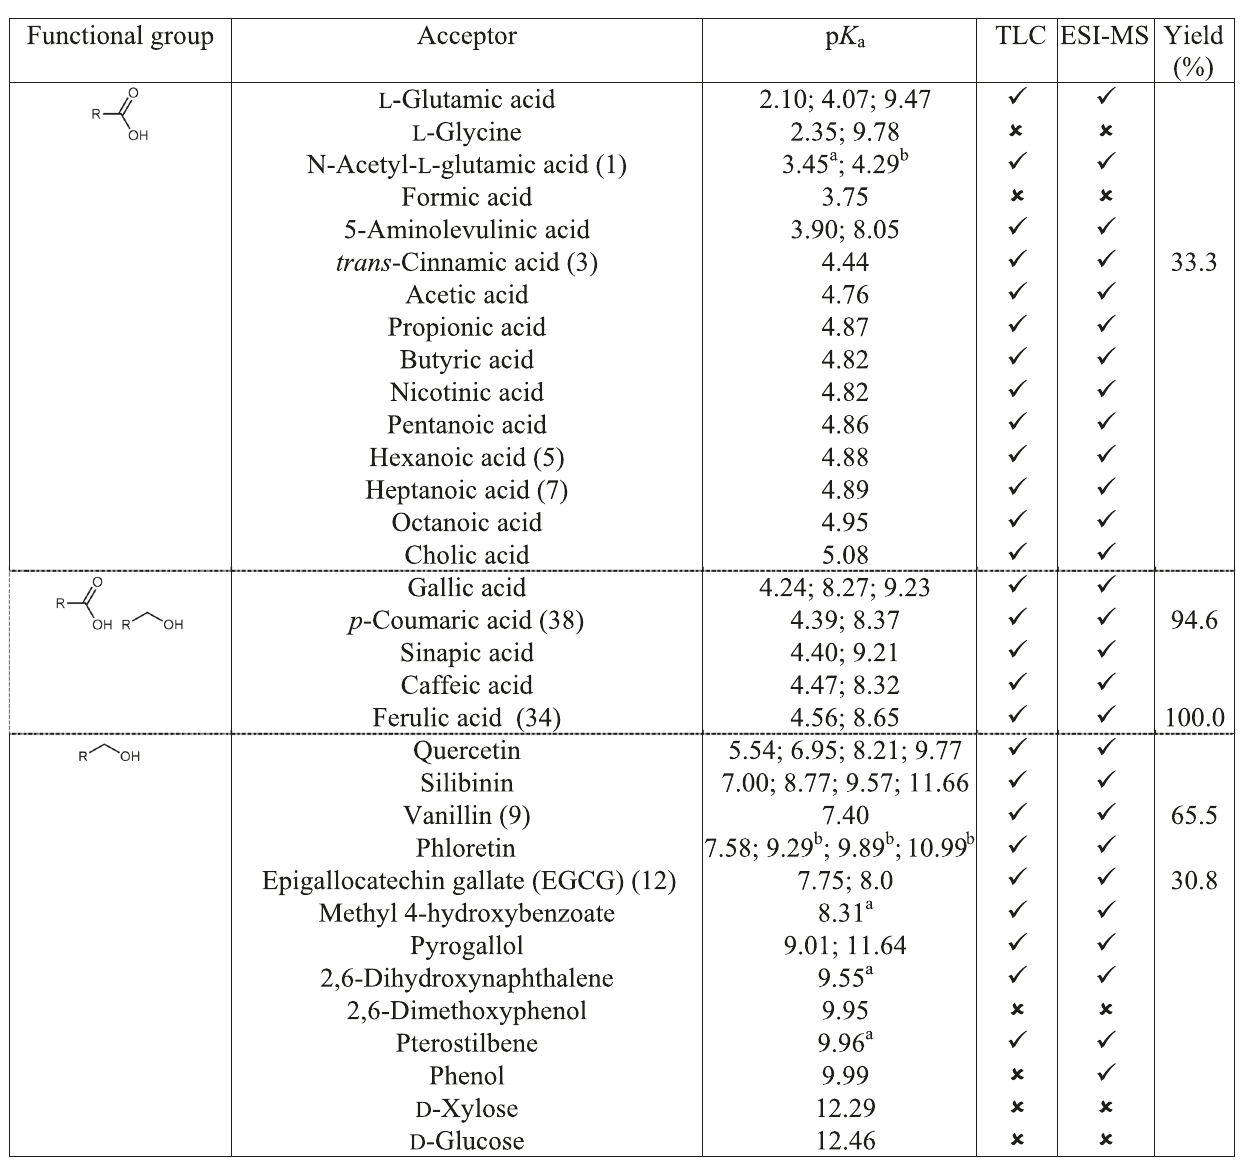
✗ : No product detected, ✓ : Product detected. Bold numbers are referred to Fig. 2 and indicate that the products from those acceptors were additionally identi fi ed by NMR. a Predicted values from SciFinder. b Predicted values from